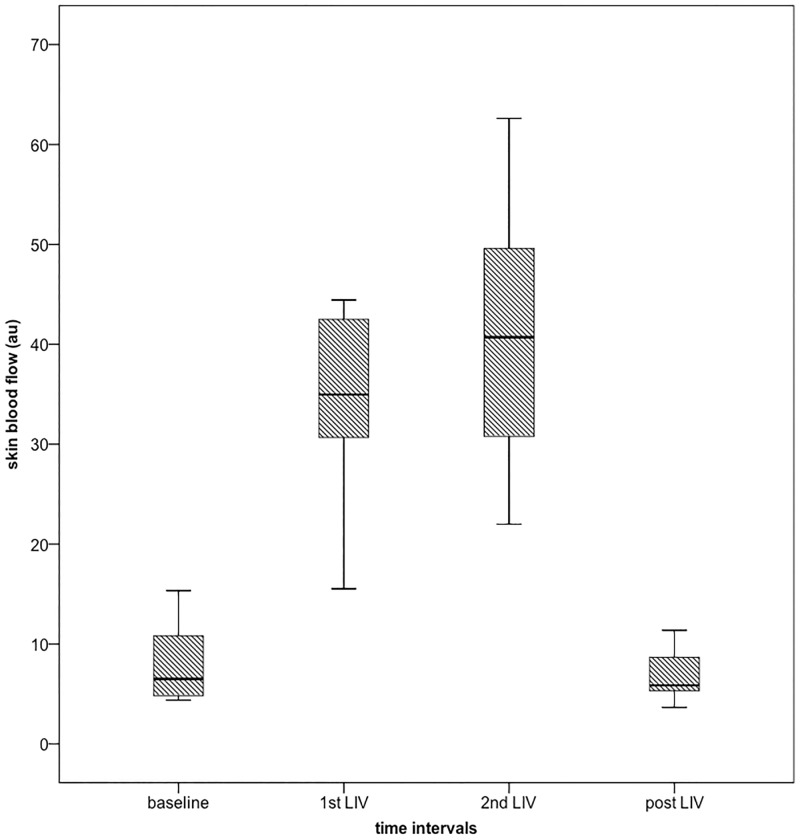
Boxplots of mean SBF during the four time intervals at foot (n = 9).Subject # 9 is an outlier (beyond 1.5 interquartile range) during 1st and 2nd bout of LIV (250 and 350 au, respectively, not shown on graph).